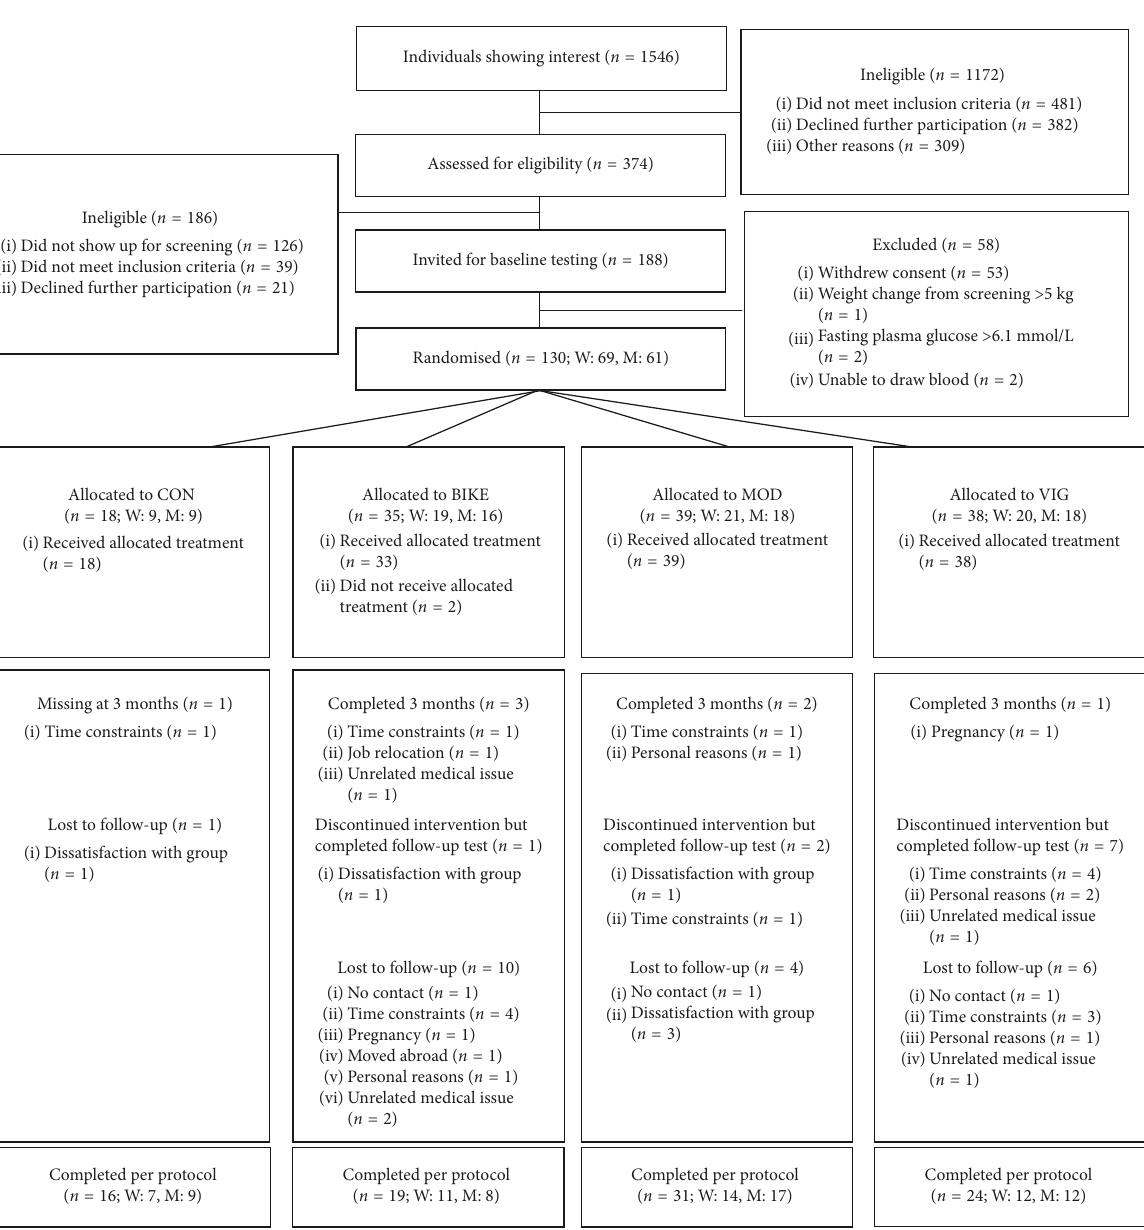
Figure 1: Flow of the progress of